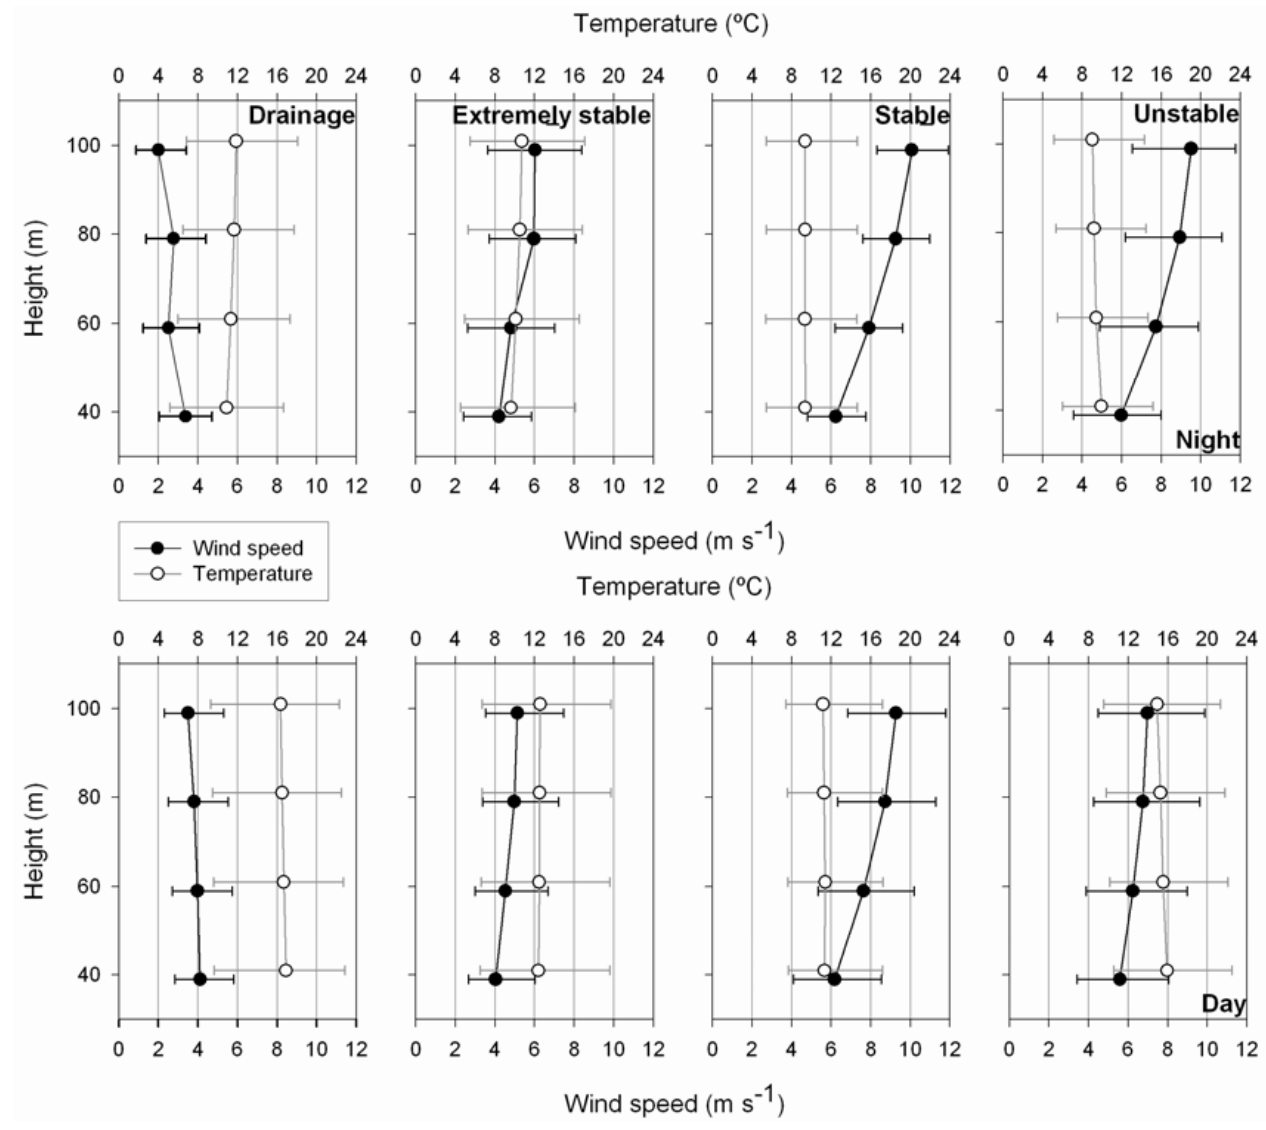
Fig. 6. Wind speed and temperature median profiles for the four stability classes proposed during the day and night. Bars show the Figure 6.- Wind speed and temperature median profiles for the four stability classes interquartile proposed during the day and night. Bars show the interquartile range.